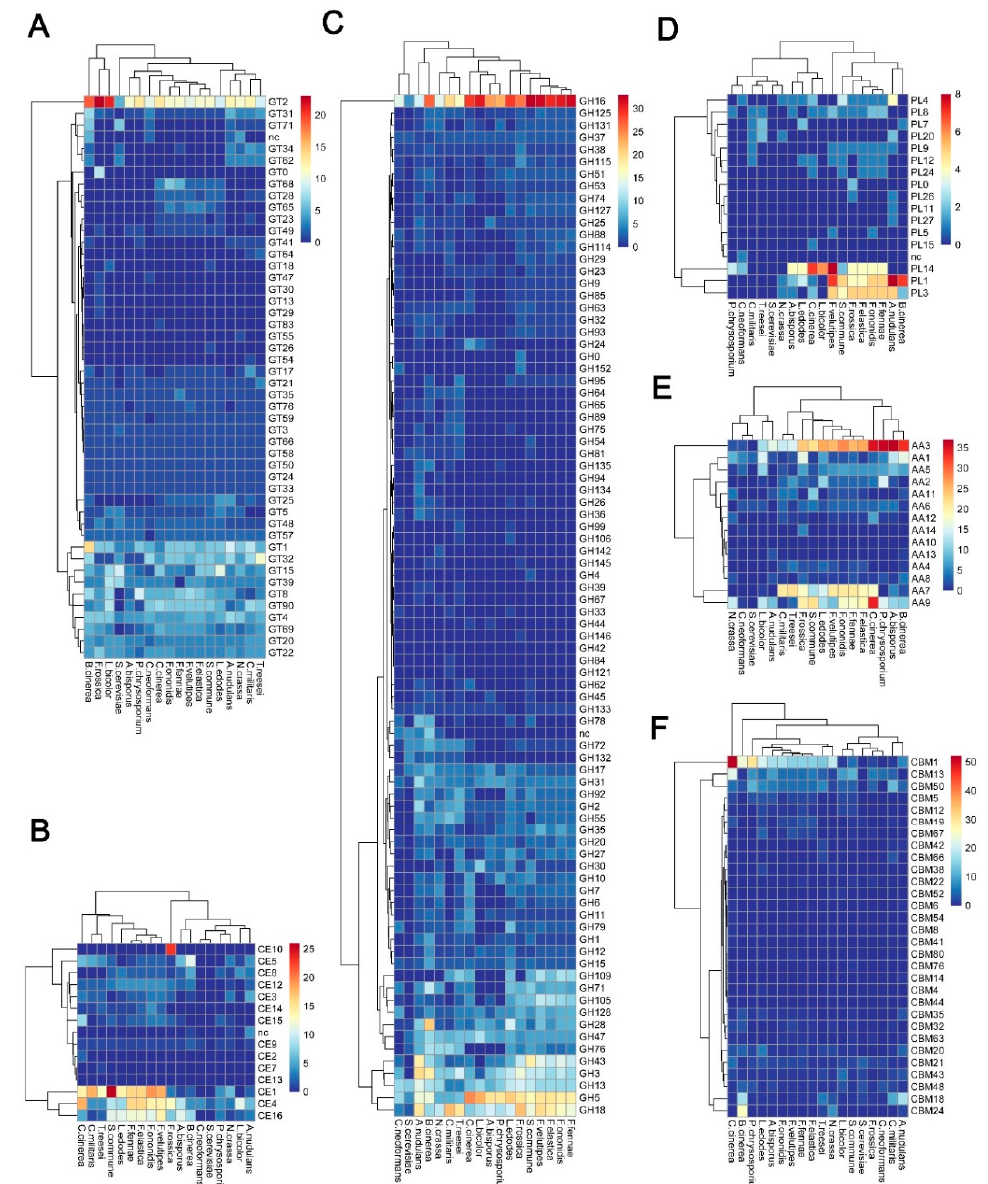
Figure 4. Distribution of CAZymes in F. rossica and other fungal species. ( A ) GT families; ( B ) CE families; ( C ) GH families; ( D ) PL families; ( E ) AA families; ( F ) CBM families.